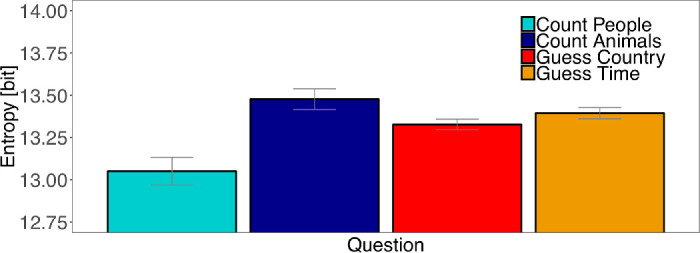
Shannon's entropy. Average entropy of fixation densities on an image in the four tasks. A value of 14 bit is expected for a uniform fixation density. Smaller values indicate that fixations cluster in specific parts of an image. Confidence intervals were corrected for within-subject designs (Cousineau, 2005; Morey, 2008).